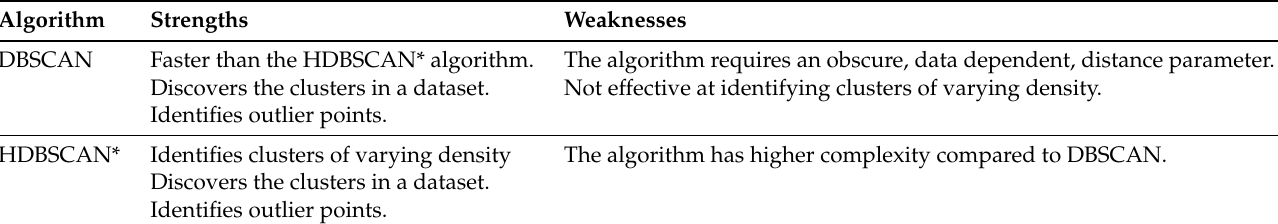
Table 1. Summary of the strengths and weaknesses of DBSCAN and